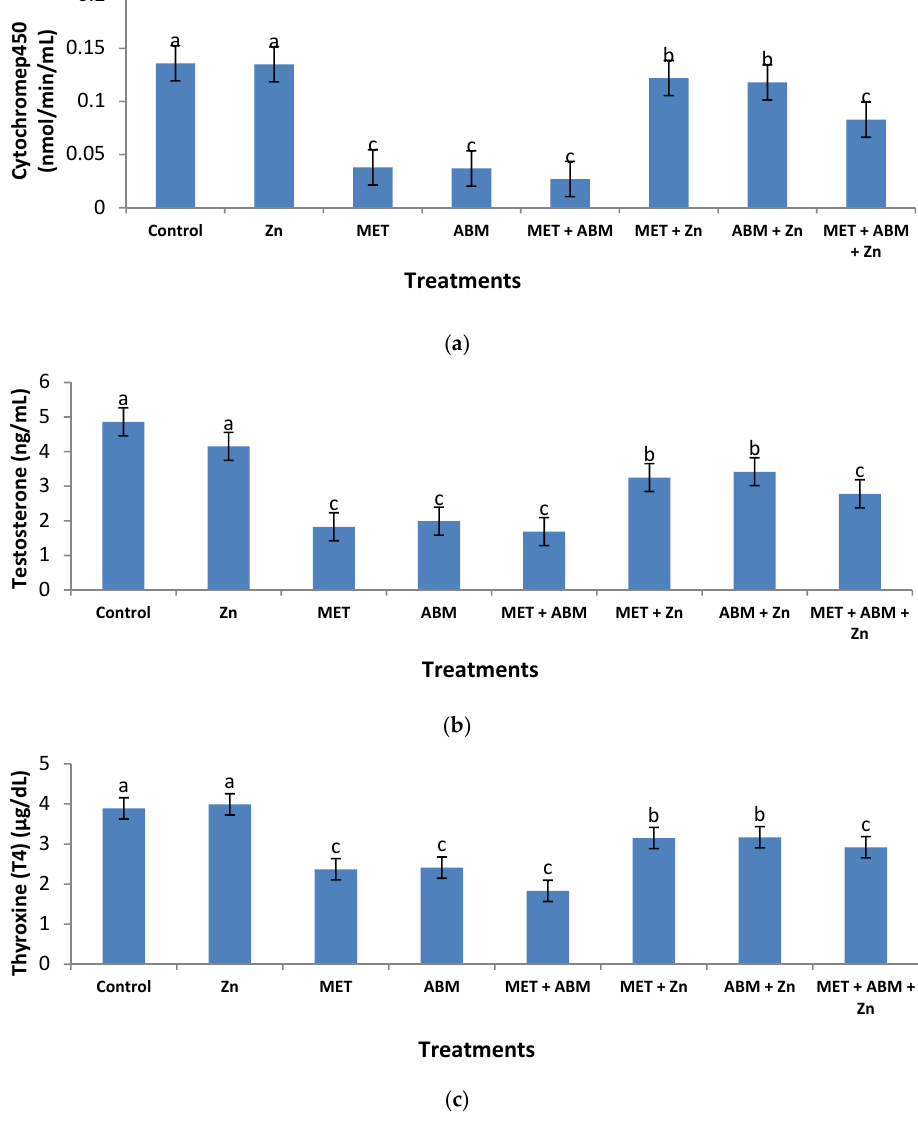
Figure 3. Effect of methomyl (MET), abamectin (ABM), and their mixture (MET+ABM), with and without zinc (Zn), on levels of cytochrome P450; testosterone (T), and thyroxine (T4) in the plasma of male rats. Statistics: bars represent the group means ± SD; n = 8. Values of similar superscript letters are not statistically different. Values of superscript “b” are significantly different than those of superscript “a” at p ≤ 0.05; Values of superscript “c” are high significantly different than those of superscript “a” at p ≤ 0.01. ( a ) = cytochrome P450; ( b ) testosterone (T); ( c ) thyroxine (T4).